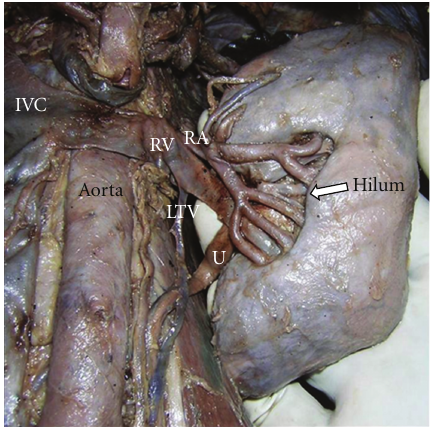
Figure 3: Left kidney: showing congested hilum and distorted shape of the kidney. RA: renal artery, RV: renal vein, IVC: inferior vena cava, U: ureter, and LTV: left testicular vein.